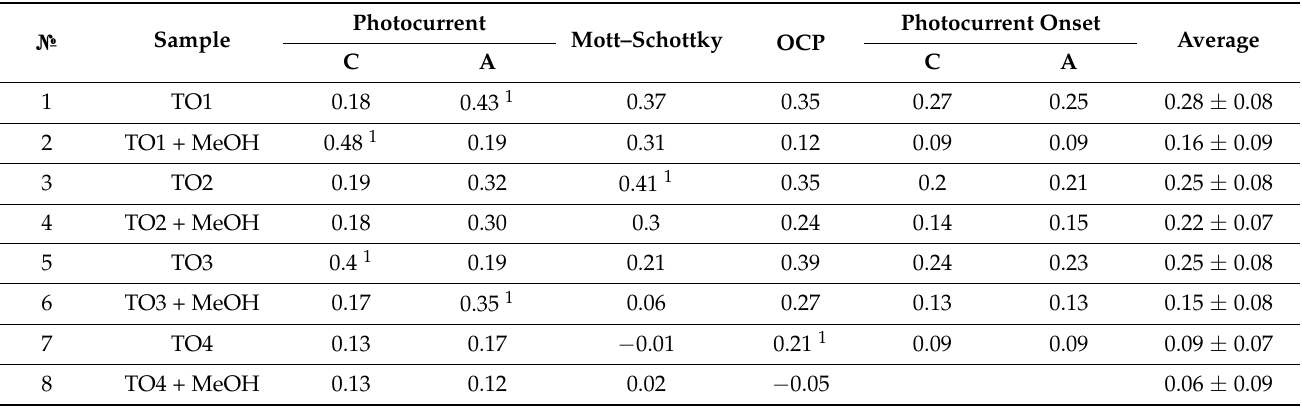
Table 4. Flat-band potentials (V, RHE) determined by methods: Photocurrent beginning (C—cathodic, A—anodic), Mott–Schottky, open circuit potential (OCP), photocurrent onset (C—cathodic, A— anodic) at chopped illumination (3